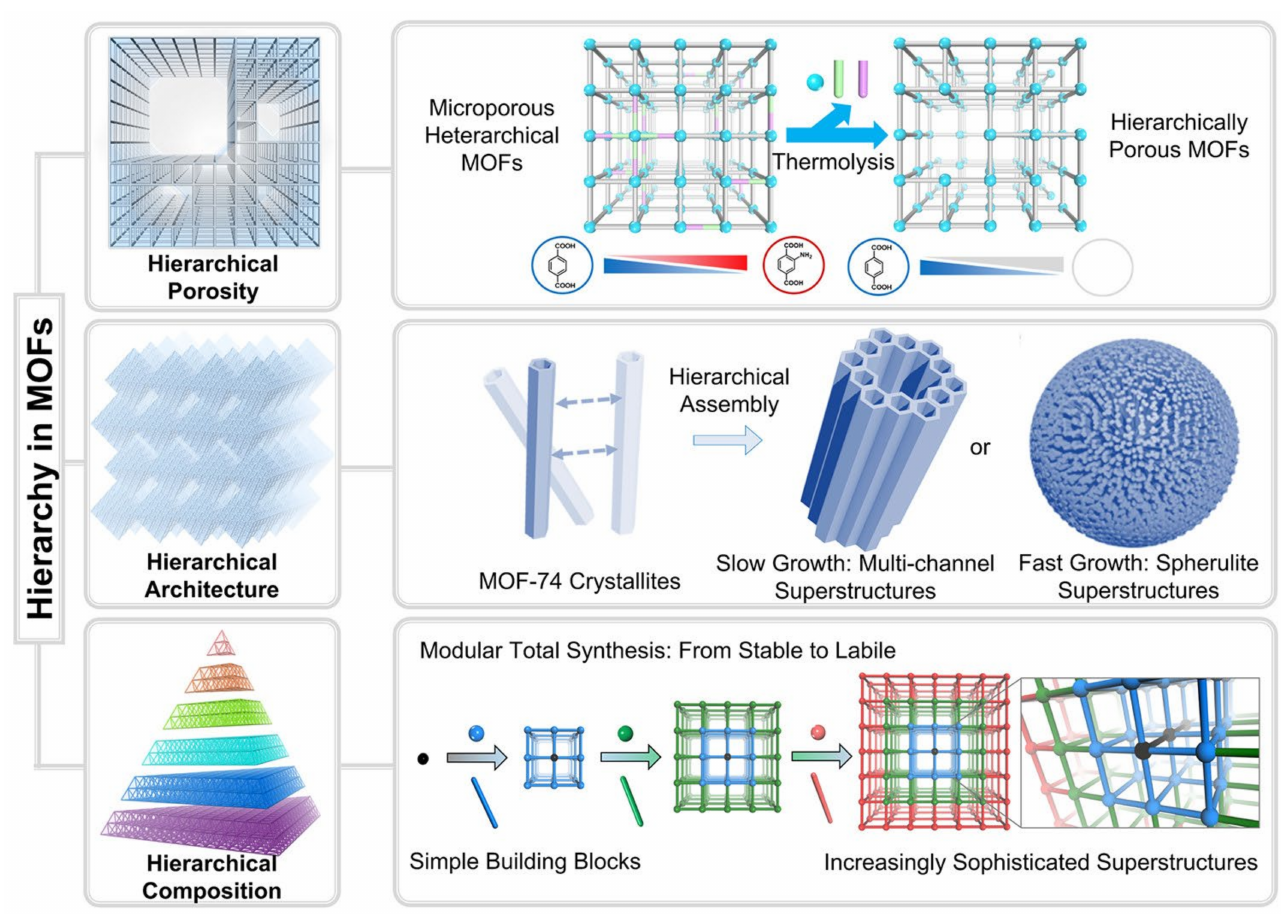
Figure 2. Hierarchically structured MOFs from three different perspectives: hierarchical porosity (top), hierarchical architecture (middle), and hierarchical composition (bottom). Reproduced with permission from ref. [48]. Copyright © 2020 American Chemical Society (further permission related to the material excerpted should be directed to the